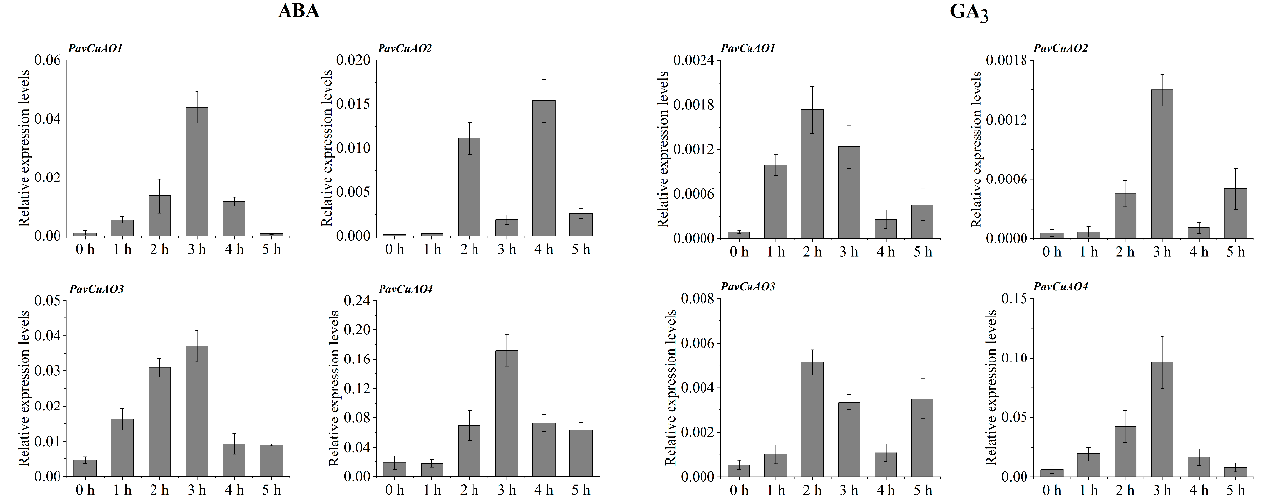
Figure 6. Expression pattern of PavCuAOs under ABA and GA 3 treatment.